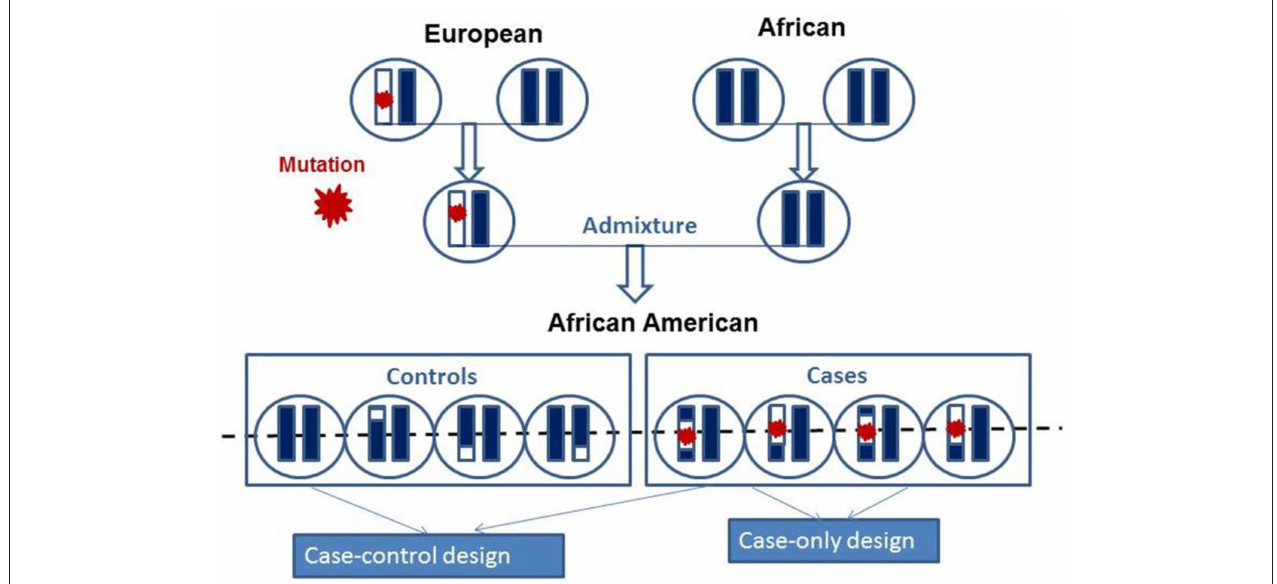
FIGURE 3 | Schematic presentations of the mosaic chromosomal structures of admixed population derived from two founders. The chromosomes of the two founders are combined and after several generations of random mating produce present day admixed individual. Admixed population can be studied using case-control and case-only admixture mapping study design to map mutation as indicated by red star.